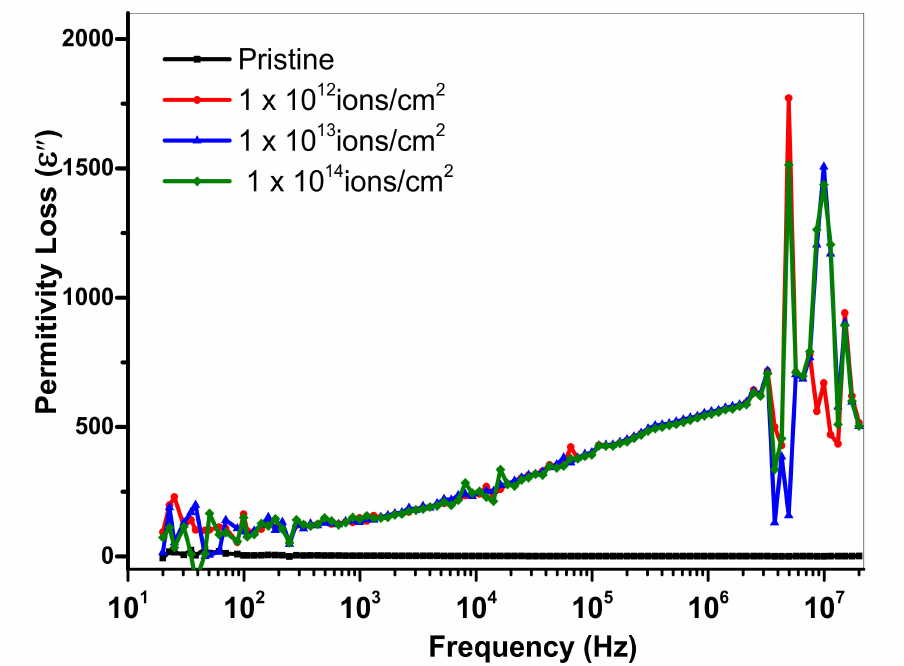
Figure 11. Variation in the real part of dielectric constant ( ε (cid:48)(cid:48) ) with